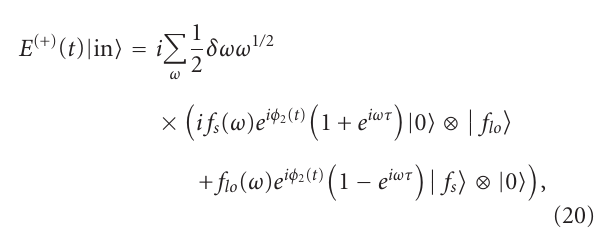
Figure 2: The normalized single-photon intensity (cid:4) I (cid:2) ( τ ) / (cid:4) I (cid:2) (0) as a function of the dimensionless time-delay τσ for the case of single-photon states in the signal and the LO ports with the same spectral width σ but with di ff erent mean frequencies. Two di ff erent examples are plotted with ω s = 3 σ : ω lo = 3 . 15 σ with (solid line) or ω . 85 σ (dashed line). The asymptotic values of (cid:4) I (cid:2) ( τ ) / (cid:4) I (cid:2) (0) lo = 2 can be obtained from the expression (22) in the main text, that is, (1 + ω lo /ω s ) /